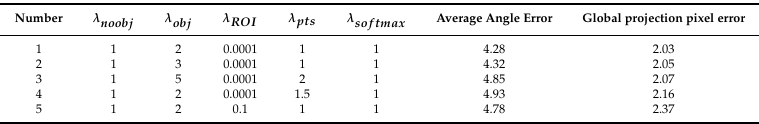
Table 10. Angle error and pixel